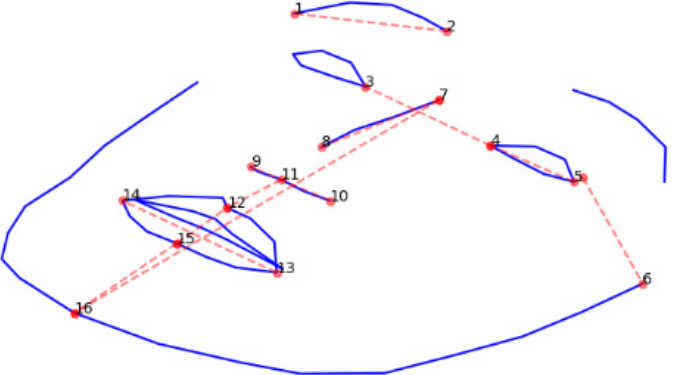
Figure 2. Localization of landmark points that were used for automated anthropometric measurements. Table 1. Automated 3D anthropometric measurements taken from 2D images in a control group and 15 genetic syndromes. The average distances between points that are labeled in Figure 1 are given.